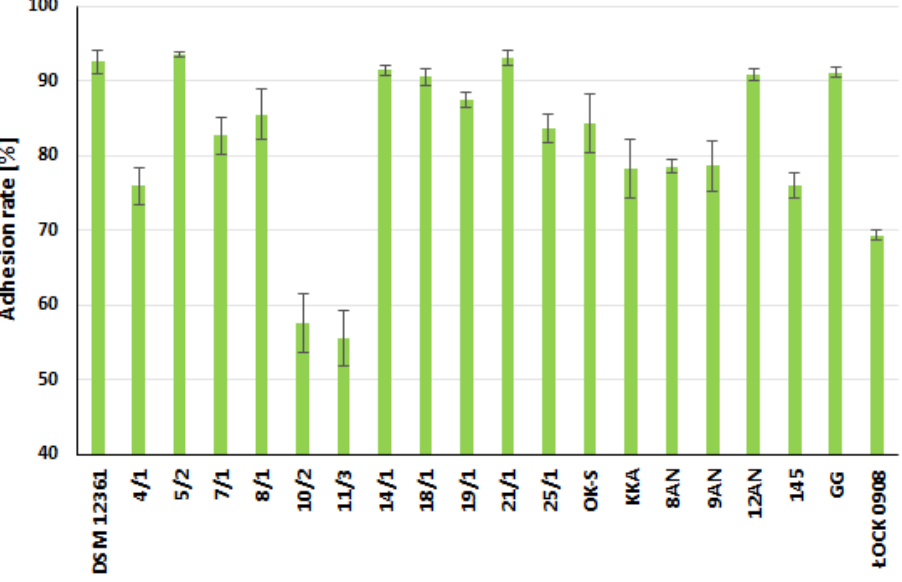
Figure 3. Adhesion of lactic acid bacteria (LAB) to Caco-2 cell monolayer after 2 h incubation. The presented results are the mean from two repeats ± standard deviation (SD).